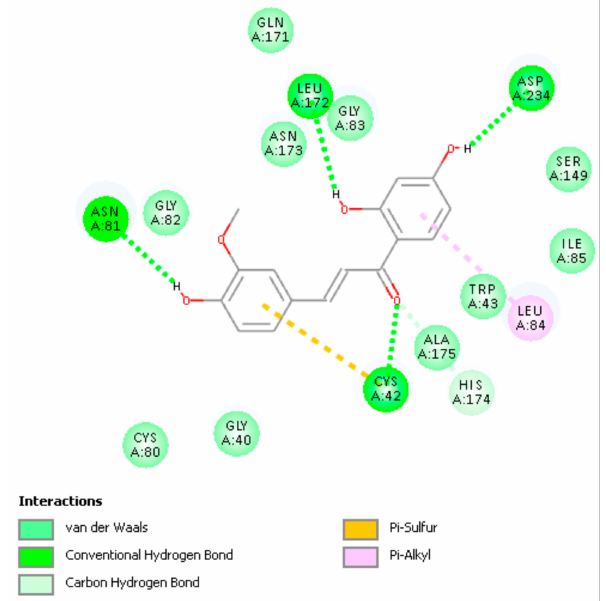
Figure 24. Two-dimensional (2D) pose 6 interactions between Homobutein and the active site of Falcipain-2.